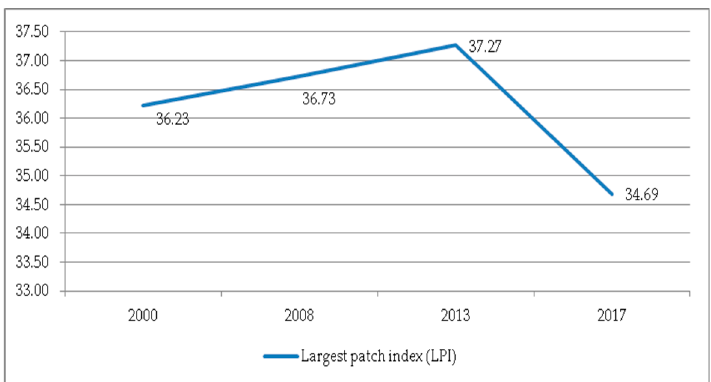
Figure 12. The LPI at the landscape level.